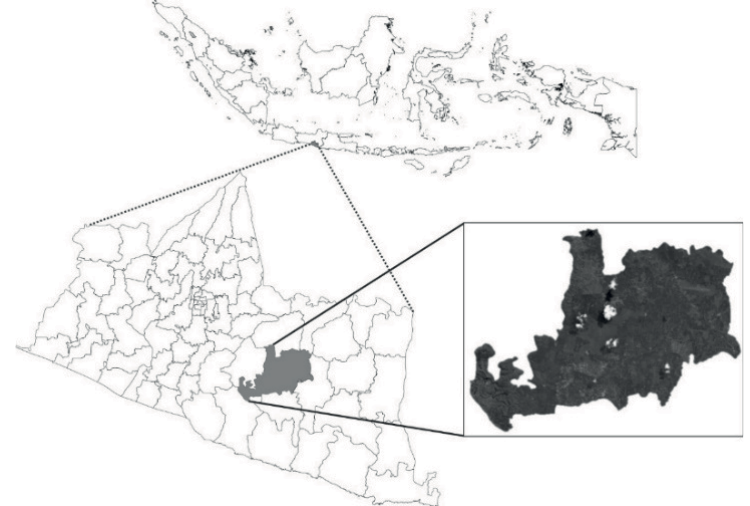
Figure 1. Geographical locations of the study area (latitude 7° 52’ 59.5992” S to 7° 59’ 41.1288” S and longitude 110° 26’ 21.462” E to 110° 35’ 7.4868”